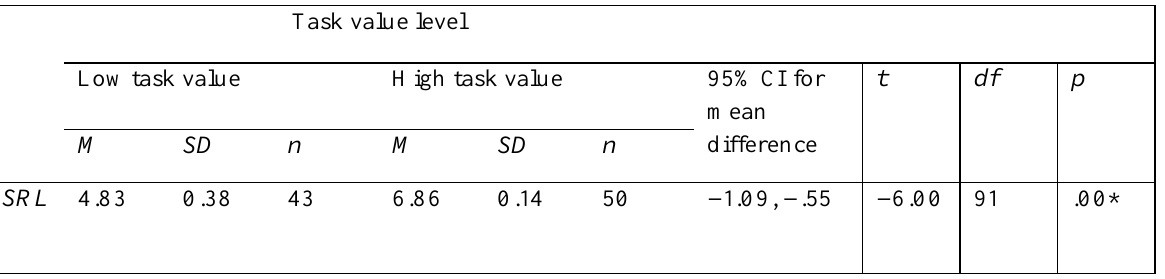
Results of Independent Sample t-Test and Descriptive Statistics for Self-Regulated Learning Scores by Task Value